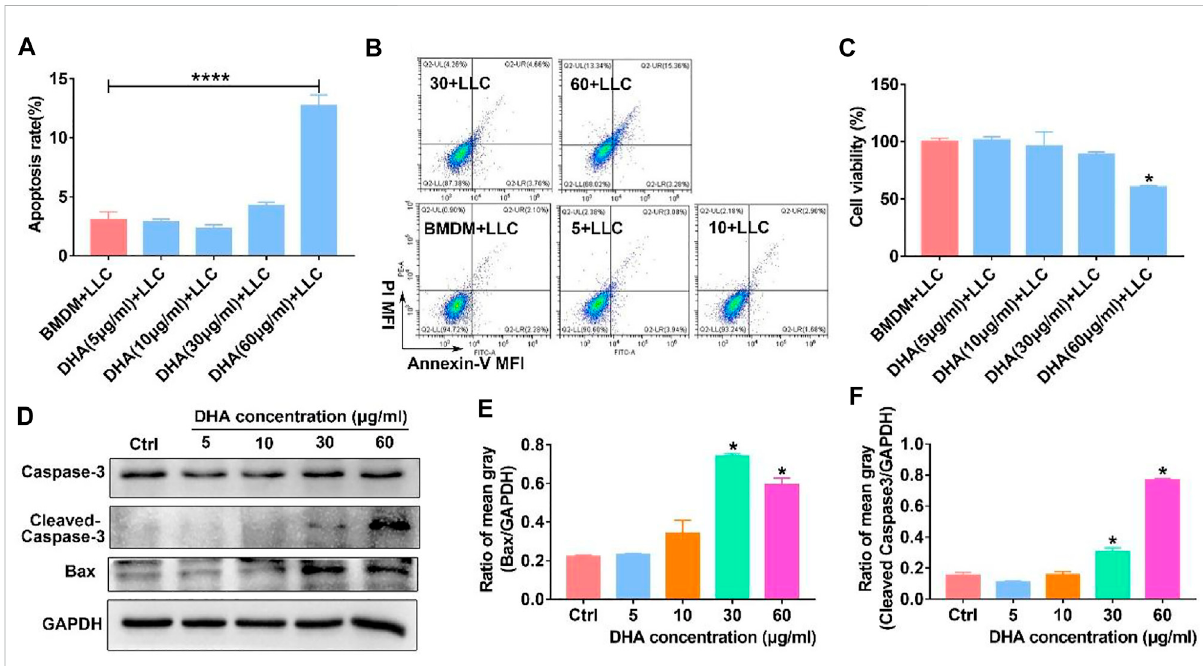
FIGURE 9 M1 phenotypic macrophages induced by DHA-facilitated apoptosis and of lung cancer cells. TAM were treated with DHA for 18 h, then co- cultured with LLCfor another18 – 24 h. (A,B) Theapoptosisrate ofLLCwasmeasured throughAnnexin-V/PIdoublestainingand fl owcytometry. (C) The viability of LLC was assayed by CCK-8. (D – F) The expression of Bax and Caspase-3 in LLC, which indicated the apoptosis levels, was detected using WB. The mean gray of bandswas quantitatively analyzed. Values were means± SD ( n = 3, * p < 0.05, **** p < 0.0001 whichwas compared with the control